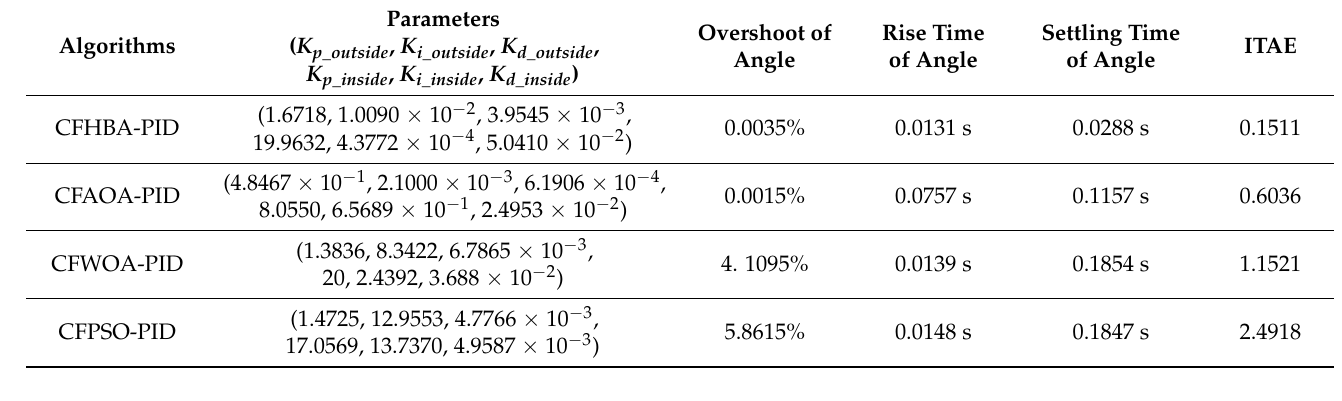
Table 7. Attitude control of balancing robots under metaheuristic algorithms and complemen- tary factor.